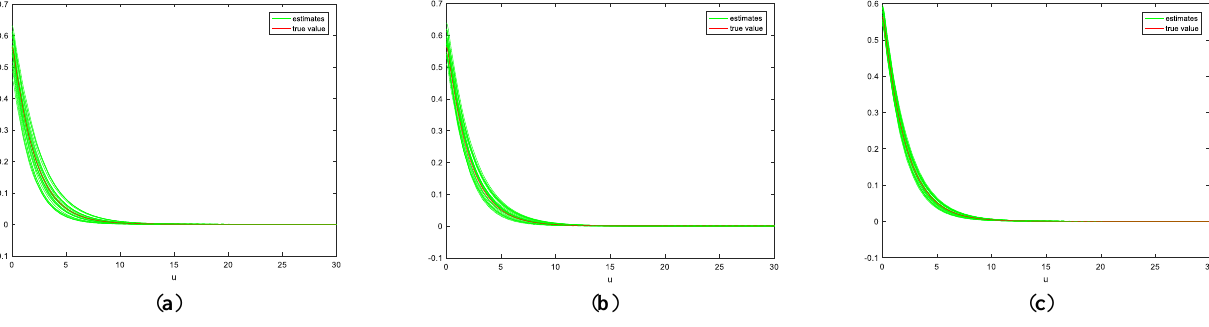
Figure 3. Estimation of the ruin probability for Gamma (1.5, 1.5) claim size density: ( a ) T = 120 , ( b ) T = 180 , ( c ) T = 360.